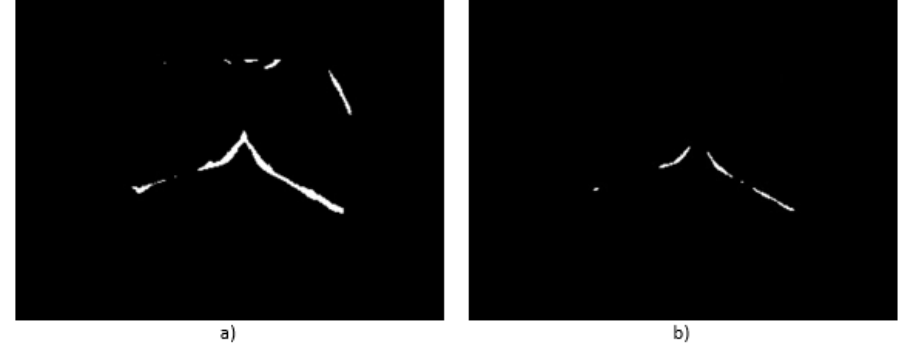
Figure 9. Automatic detection of inferior breast limits: ( a ) regions above the selected threshold value; and ( b ) thicker regions detected using the distance